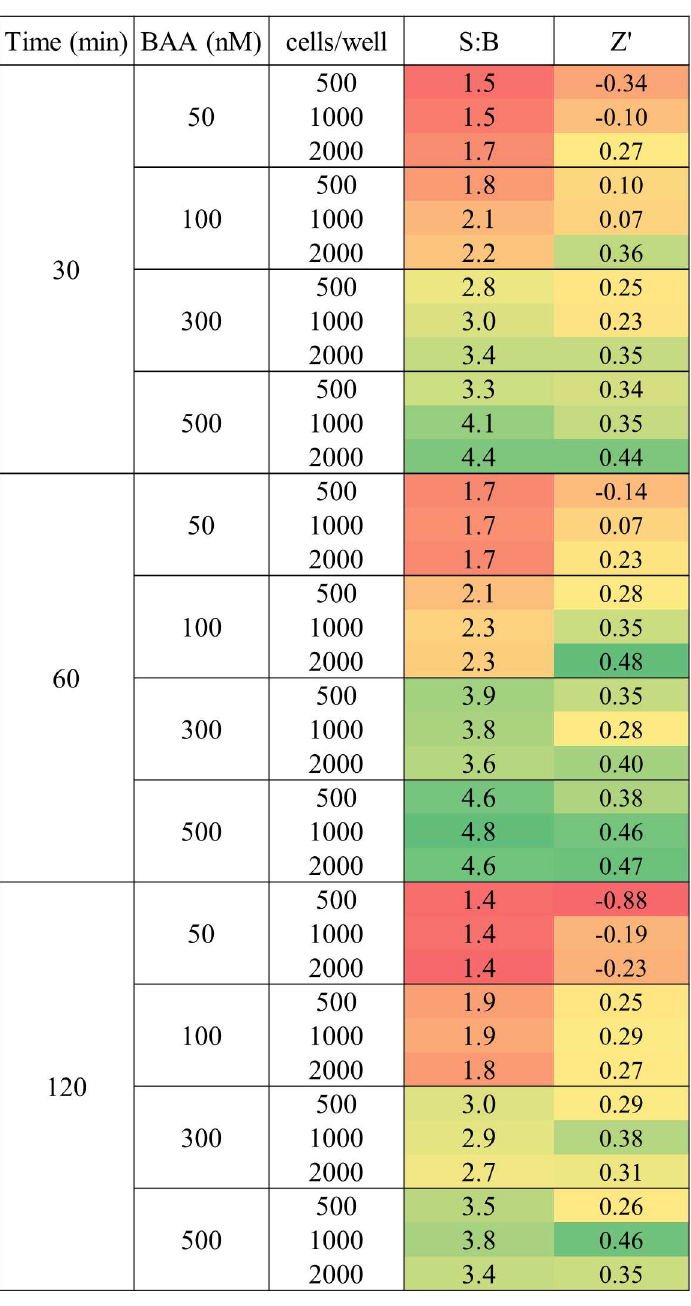
Fig 3. Assayoptimization. S:B and Z’ factor heat map accordingto variationin assay parameters. Green represents best assay conditions. Parameters were calculatedusing signalfrom control DMSO wells and inhibitorDEAB (4.6 μ M final) wells with n =